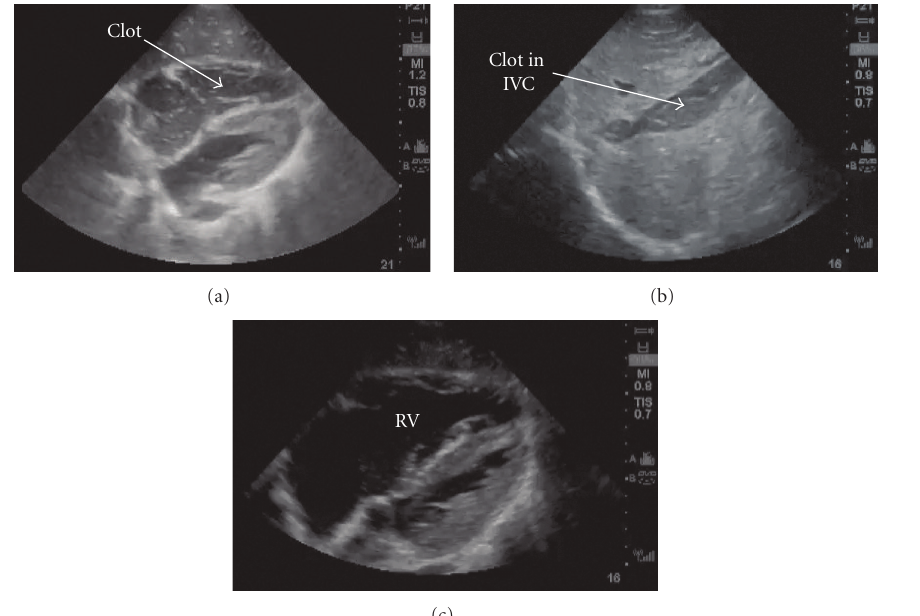
Figure 1: Initial bedside ultrasound demonstrated thrombus in the RV (a) and the IVC (b). A repeat ultrasound demonstrated acute RV enlargement (c).